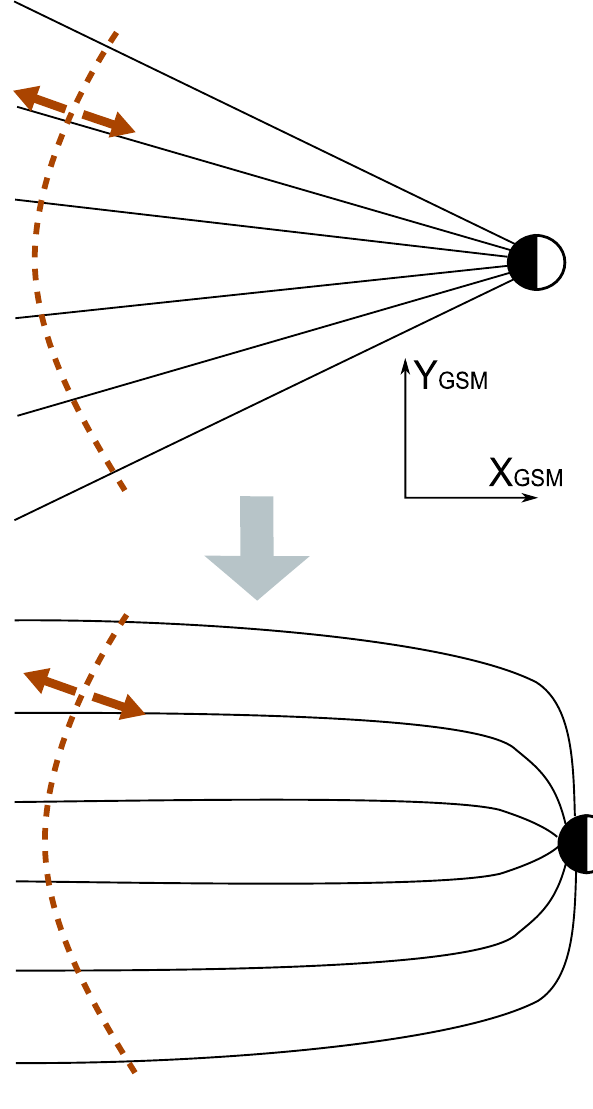
Fig. 8. A schematic illustration of how the orientation of the mag- netic field in the tail may have changed due to the reconnection event. An x-line and outflows are also drawn. The figure shows a view looking down on the xy